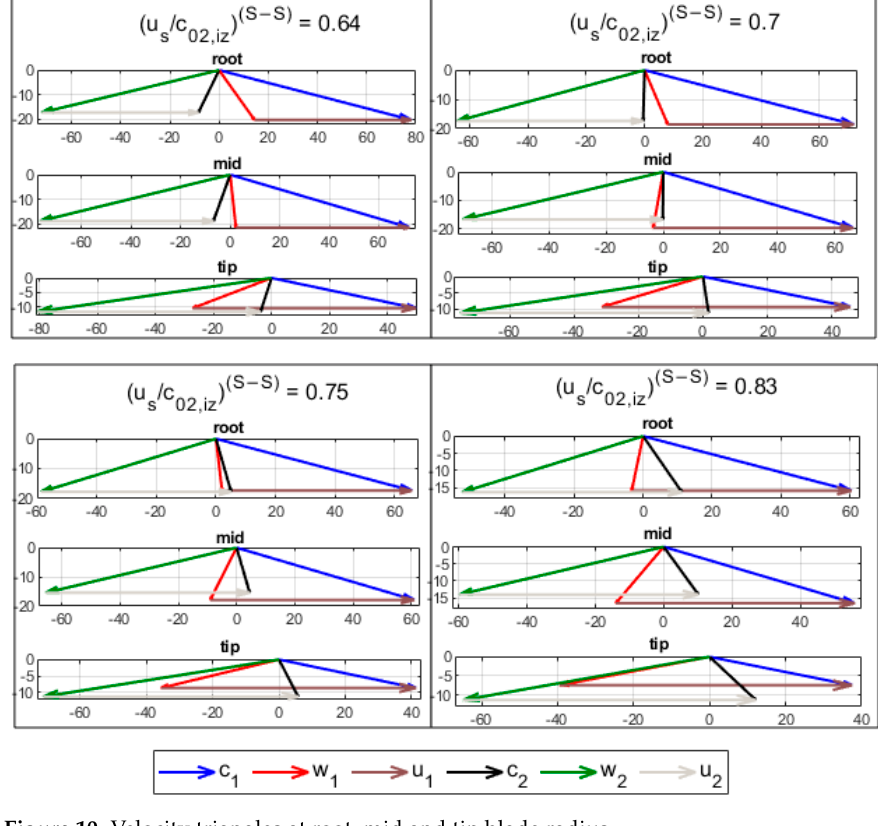
Figure 10. Velocity triangles at root, mid and tip blade radius.